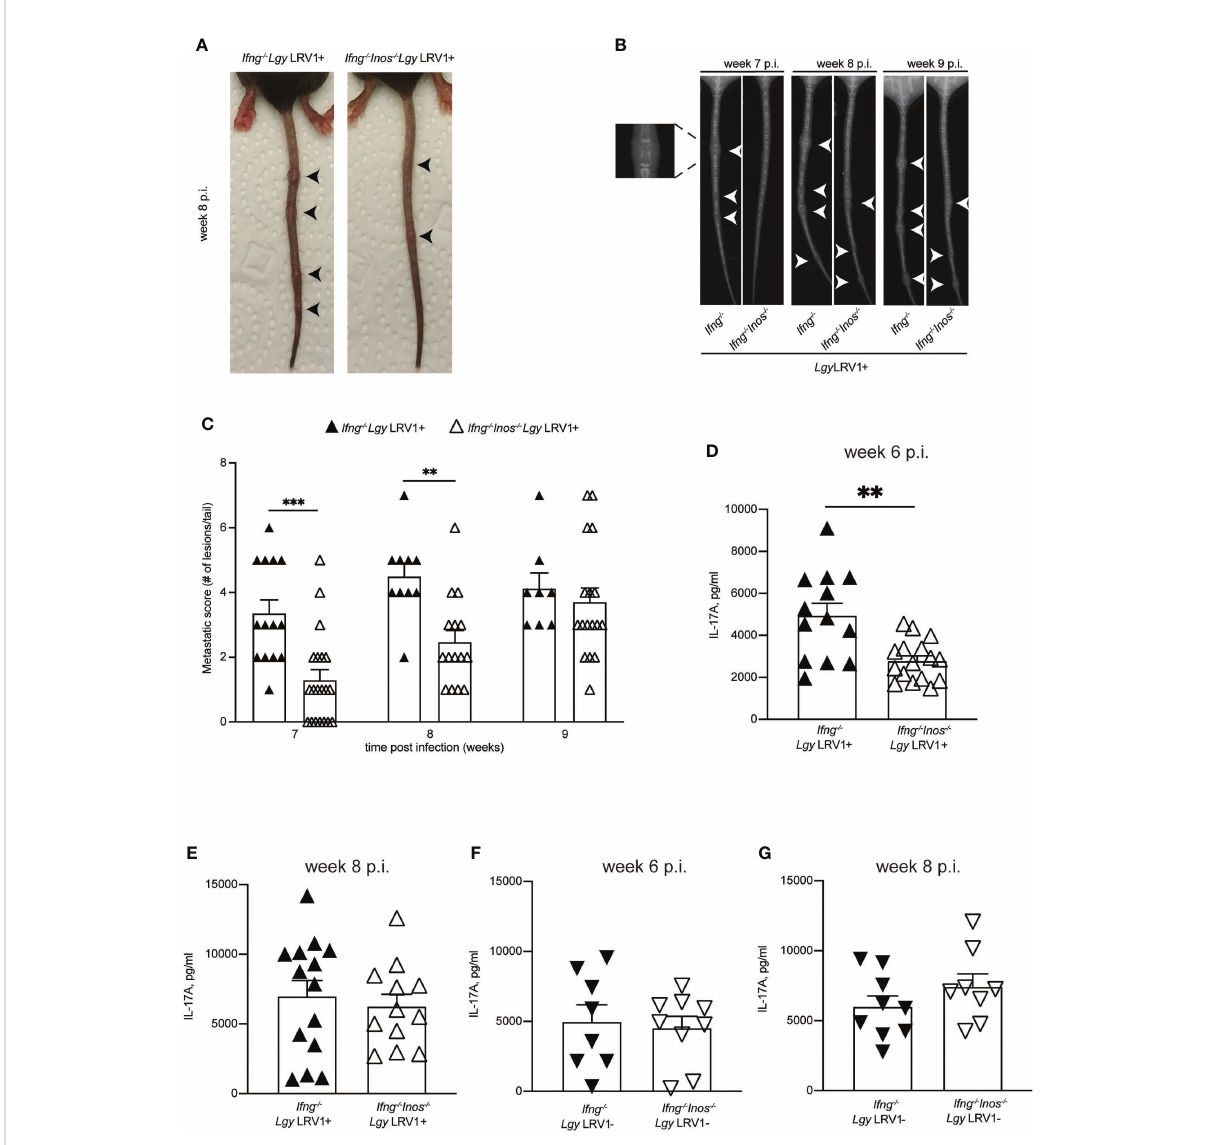
FIGURE 6 Ifng -/- Inos -/- mice showed delayed metastasis formation compared to Ifng -/- upon Lgy LRV1+ infection. Hind footpads of Ifng -/- and Ifng -/- Inos -/- DKO mice were infected with 3 × 10 6 stationary phase promastigotes of Lgy LRV1+. (A) Photographic images of representative mice showing metastatic lesions on the tail at week 8 post infection. Arrow heads indicate the metastatic nodules. bone destruction. (B) X-ray images of representative mice showing metastatic lesions on the tail at indicated time points. Arrow heads and enlarged image indicate bone destruction. (C) Number of metastatic lesions per mouse. (D – G) Ifng -/- and Ifng -/- Inos -/- DKO mice were infected into hind foot pads with 3 × 10 6 stationary phase promastigotes of Lgy LRV1+ or Lgy LRV1- as indicated. At 6- and 8-weeks post infection, lymphocytes were extracted from popliteal LNs draining the primary lesion and then re-stimulated ex vivo with UV-irradiated promastigotes of Lgy LRV1+ or Lgy LRV1- respectively. Upon 72h, IL-17A secretion was quanti fi ed by ELISA in cell-free supernatants. Data show mean ± SEM from three independent experiments with at least 3 mice per group for Lgy LRV1+ infection and from two independent experiments with at least 3 mice per group for Lgy LRV1- infection. Statistical signi fi cance is calculated using 2-way Anova test in (C) and Student ’ s t test in (D – G) . Not signi fi cant (NS), **p < 0.01, and ***p <